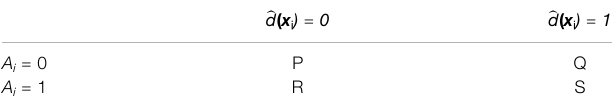
TABLE2| Theelementsof y test cross-tabulatedbytheiradministeredtreatment A i and our model ’ s estimate of the better treatment (cid:12) d ( x i